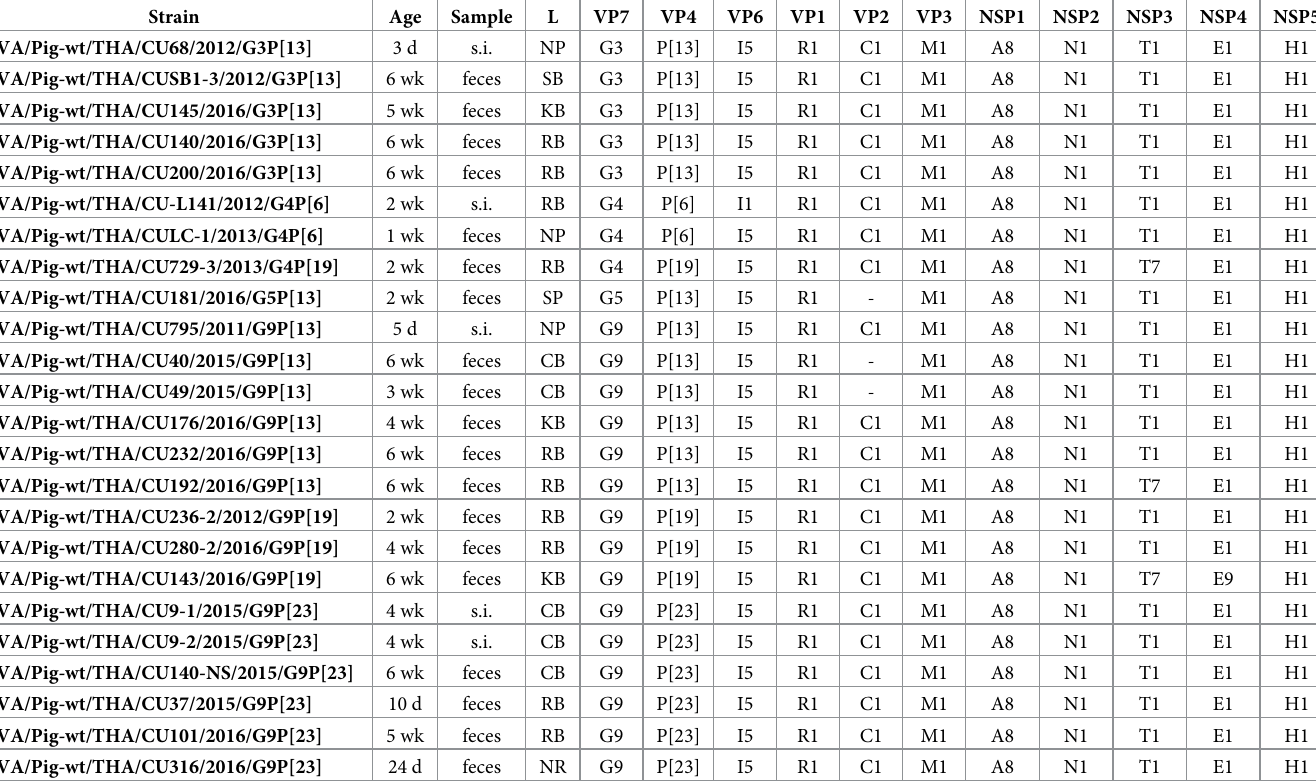
Table 1. The genome constellation of 24 Thai porcine strains.